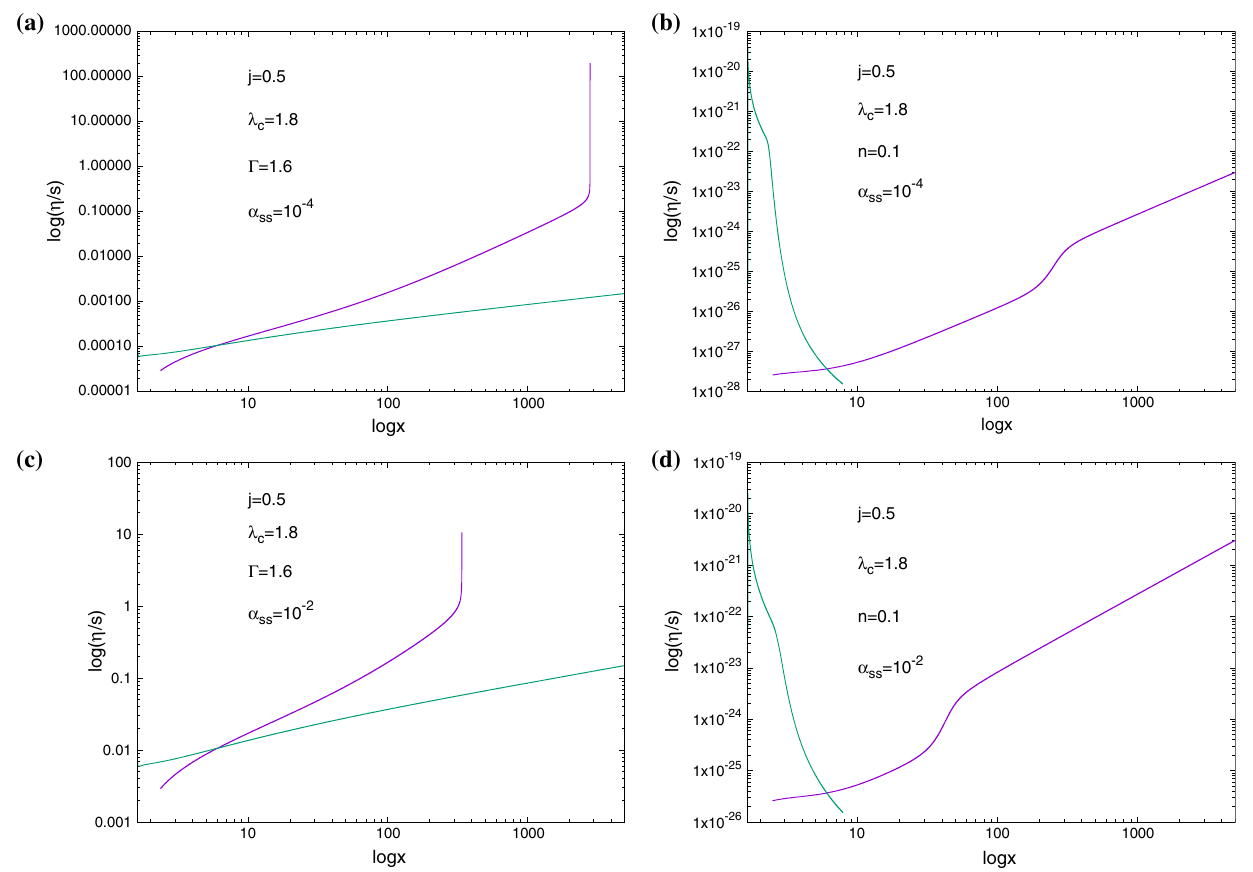
) vs log ( x ) for viscous accretion disc Fig. 2 a and c are plots of log ( η vs log ( x ) for viscous accretion disc flow with viscosity α ss = 10 − 4 s and α ss = 10 − 2 respectively, around a rotating BH with j = 0 . 5 for flow with viscosity α ss = 10 − 4 and α ss = 10 − 2 respectively, around a ) MCG.Accretionandwindcurvesaredepictedbypurpleandgreenlines rotating BH with j = 0 . 5 for adiabatic case. b and d are plots of log ( η s